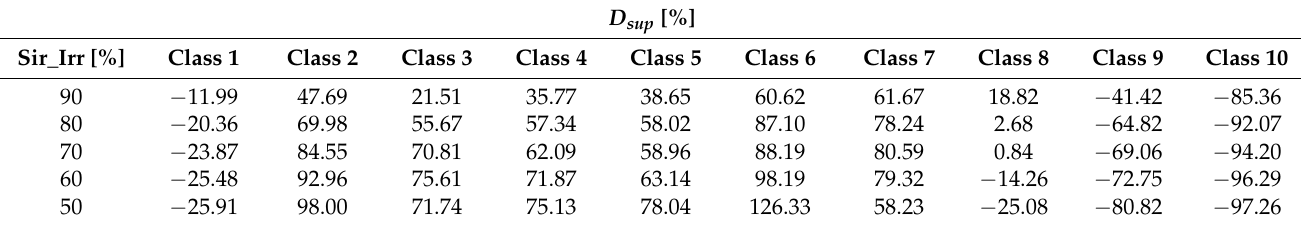
Table 6. Values of the weighted difference in percentage Dsup, for the deficit irrigation from 100% to 50% of the actual value and the ten classes, for the RF model.